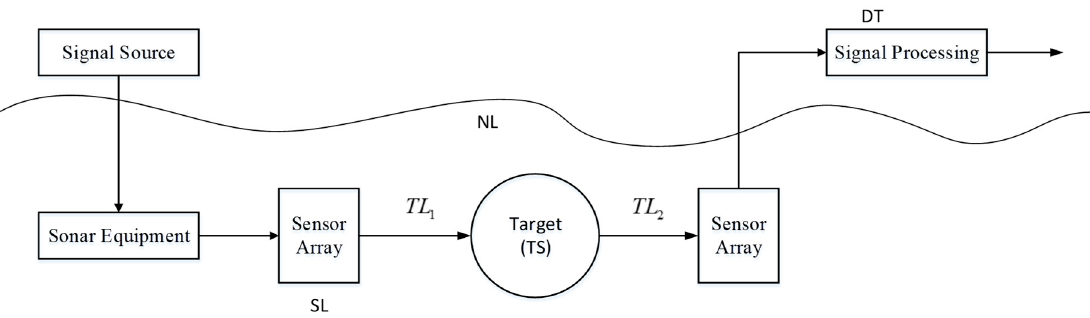
Figure 1. A simple schematic of active sonar detection.